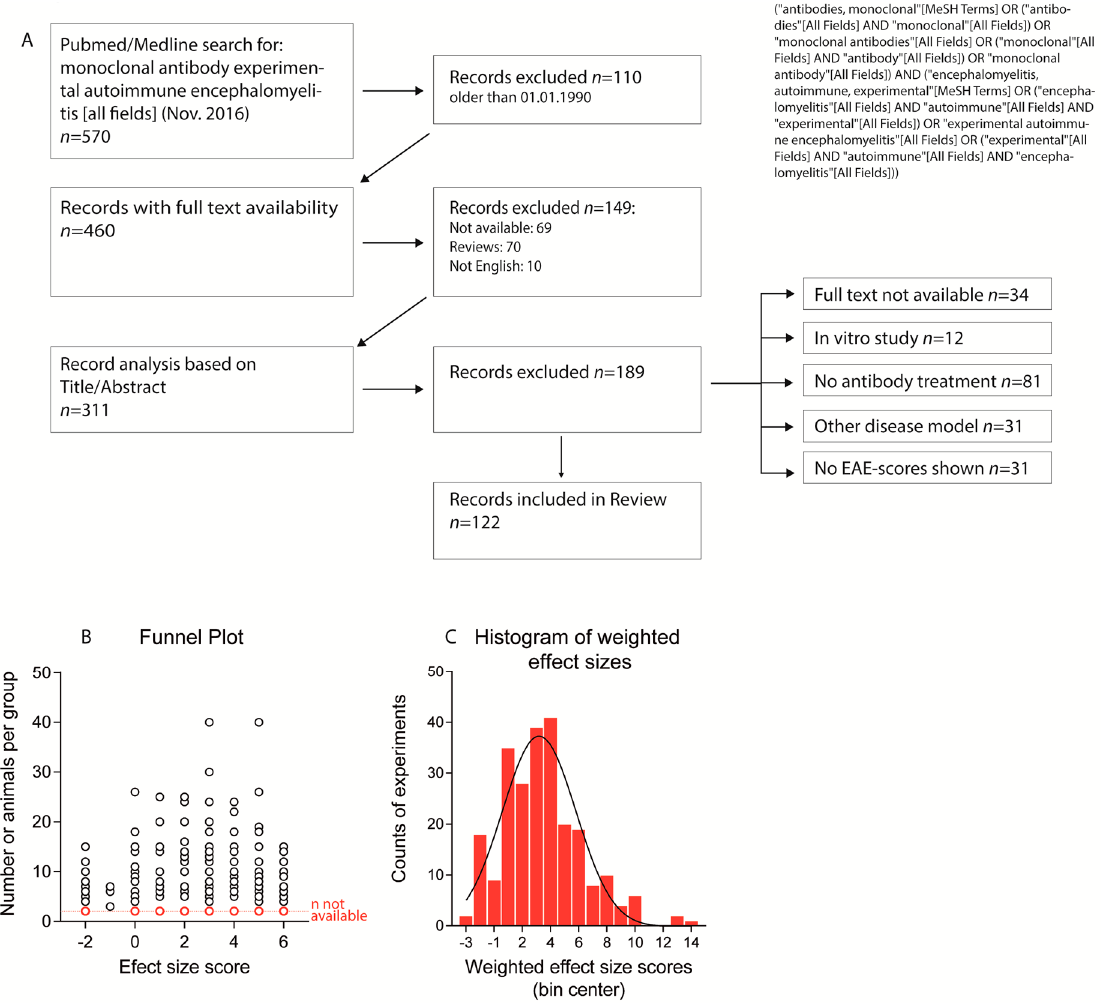
Figure 1. ( A ) Flow diagram showing the strategy of the literature search and paper selection criteria; ( B ) Funnel plot showing the number of animals per experiment vs. effect sizes. Experiments for which n -numbers were not reported are marked in red and presented below the other experiments; ( C ) Histogram showing the frequency of weighted effect sizes of experiments suggesting a Gauss